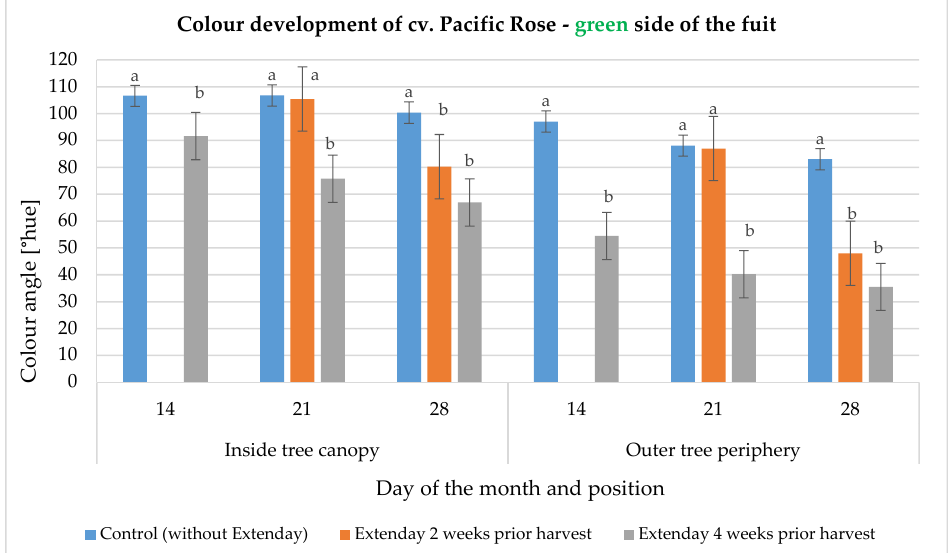
untreated fruit of cv. Pacific Rose, especially fruit from the inside of the tree canopy (Fig- ure 9), meant greener apple fruit. Spreading Extenday TM two weeks prior to harvest was sufficient under NZ weather conditions (SH at 41° S) to significantly enhance fruit colour- ation. On the trunk-oriented inner green side of the fruit two weeks prior to harvest, re- Figure 8. Colour development dependent on fruit position within the tree of cv. Fuji as measured on 15, 22 and 29 March flective mulch improved fruit colour viz., decreased the green side from 105° hue to 80° Figure 8. Colour development dependent on fruit position within the tree of cv. Fuji as measured on the red side of the fruit as affected by reflective mulch. (Treatments with different letter for the same position of the hue, whereas it remained at 100° hue in the control group. Both treatments of reflective on 15, 22 and 29 March on the red side of the fruit as affected by reflective mulch. (Treatments with fruit within the same day are statistically different ( p < 0.05) (n = 60 fruit per treatment per position). mulch significantly enhanced colouration on the red side of the fruit in cv. Pacific Rose different letter for the same position of the fruit within the same day are statistically different ( p < (Figure 10), even on the outer tree periphery (Figure 13). Overall, the effect on the green Similarly, the effect of reflective mulch on colour development on the green inner, 0.05) (n = 60 fruit per treatment per position). side inside the tree canopies of both varieties was more pronounced than on the red side trunk-oriented side of the fruit was significant. Larger colour angles of 100–110 °hue in of the fruit.